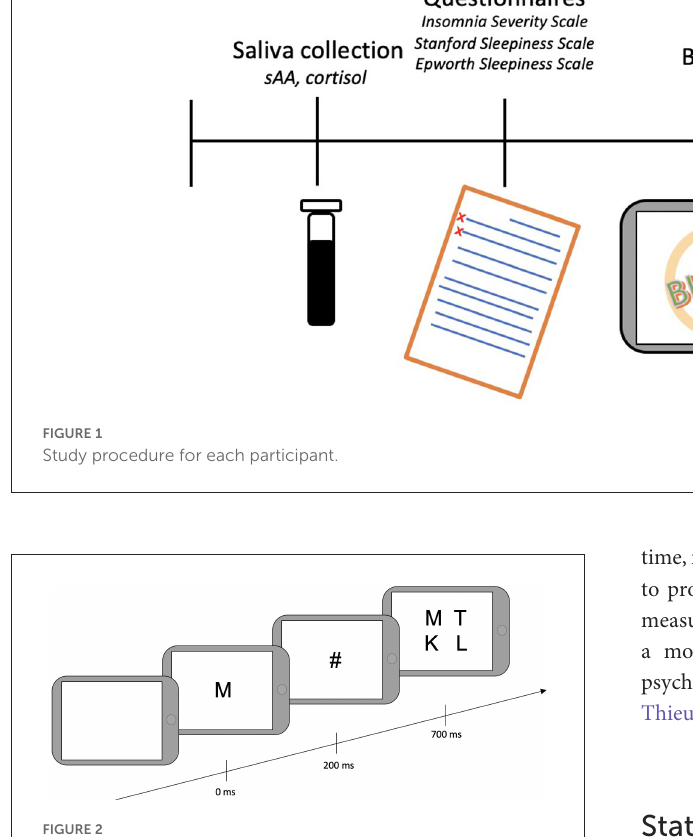
FIGURE2 Typical trial of the BLAST